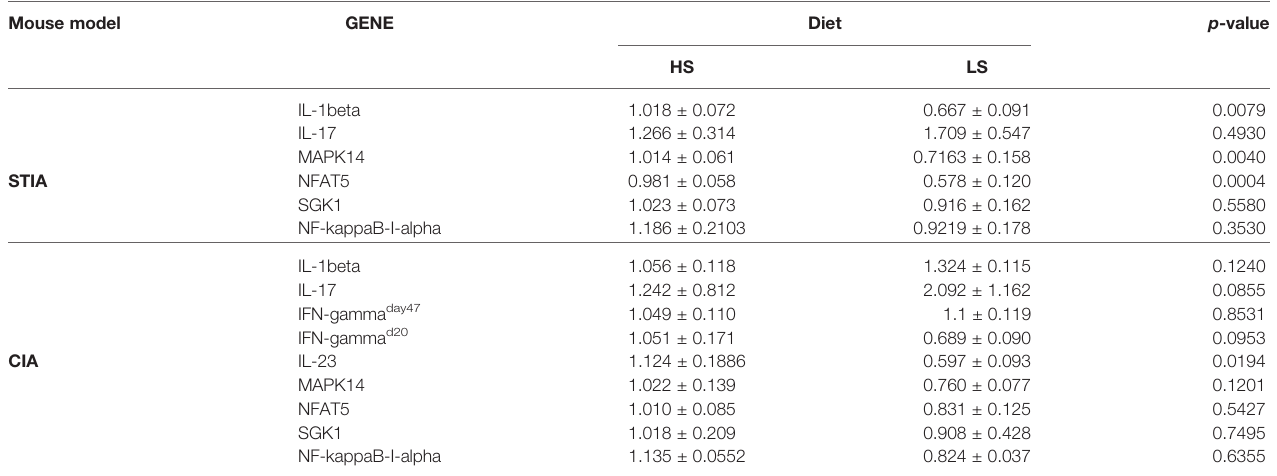
TABLE 2 | Fold change in mRNA expression in spleens. Mouse